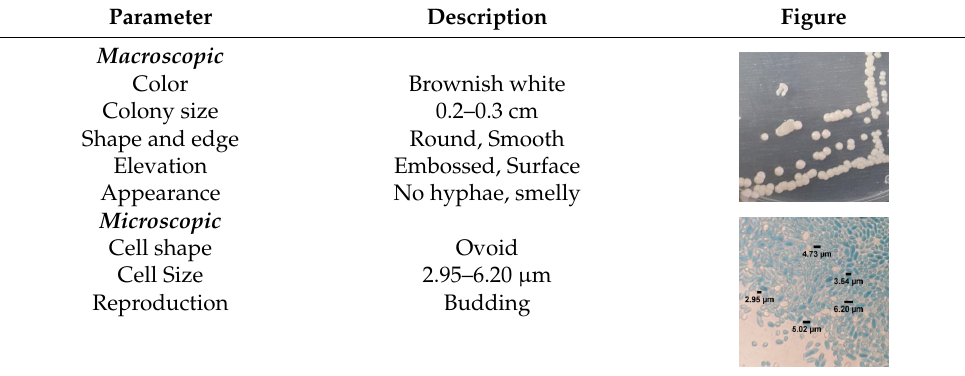
Table 1. Characteristics of native yeast isolated from tofu wastewater.